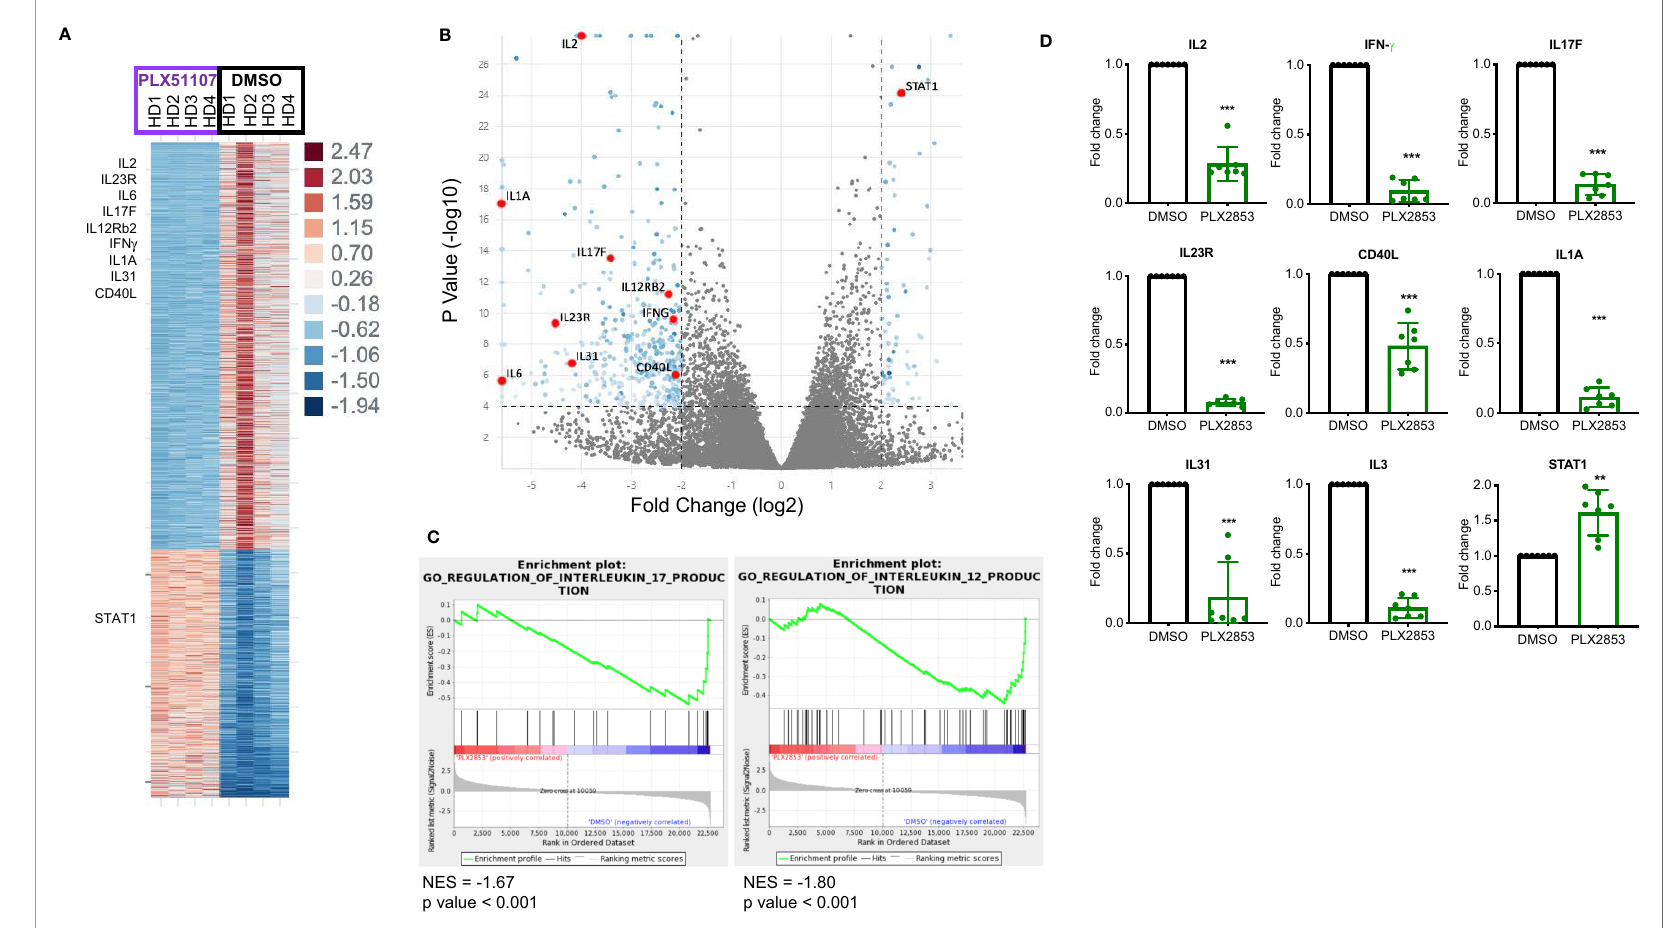
FIGURE 5 | BET inhibition signi fi cantly impacts in fl ammation associated gene expression signatures. Human T cells were isolated from healthy PBMCs (n=4). T cells were stimulated with CD3/CD28 Dynabeads ± PLX51107 (500nM) for 48hrs, RNA isolated and RNA-seq performed. (A) Heat map of differentially expressed genes with at least 2-fold change, p<0.05. (B) Volcano plot of the top dysregulated genes with at least 4-fold change, p<0.0001. (C) GSEA analysis of RNA-seq counts. Gene set enrichment analysis (GSEA) enrichments plots of IL-17 and IL-12 gene expression signatures. (D) Validation of RNA-seq data in additional T cells isolated from healthy PBMCs (n=7) by real-time qPCR for indicated genes. T cells were treated with DMSO or PLX2853 (10nM) for 48hrs. Fold change compared to DMSO, gene expression normalized to b - actin. **p < 0.01, ***p <